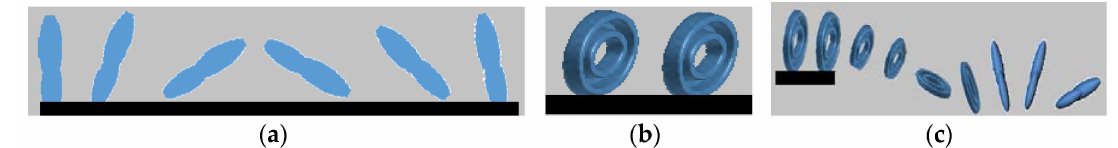
Figure 5. Liquid marbles rolling off an inclined plane. ( a ) “Peanut” shape; ( b ) “Doughnut” shape; ( c ) Transformation of “doughnut” into “peanut” shape, as the plane is